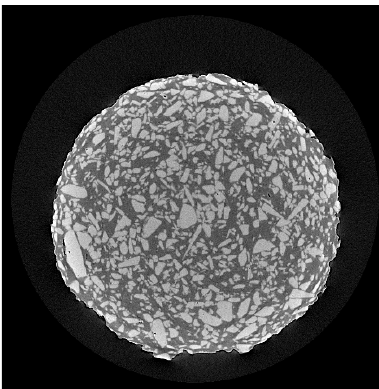
Figure 5. X-ray tomography image of filament with 50% MET, 40% AFF, and 5% of both auxiliary excipients.